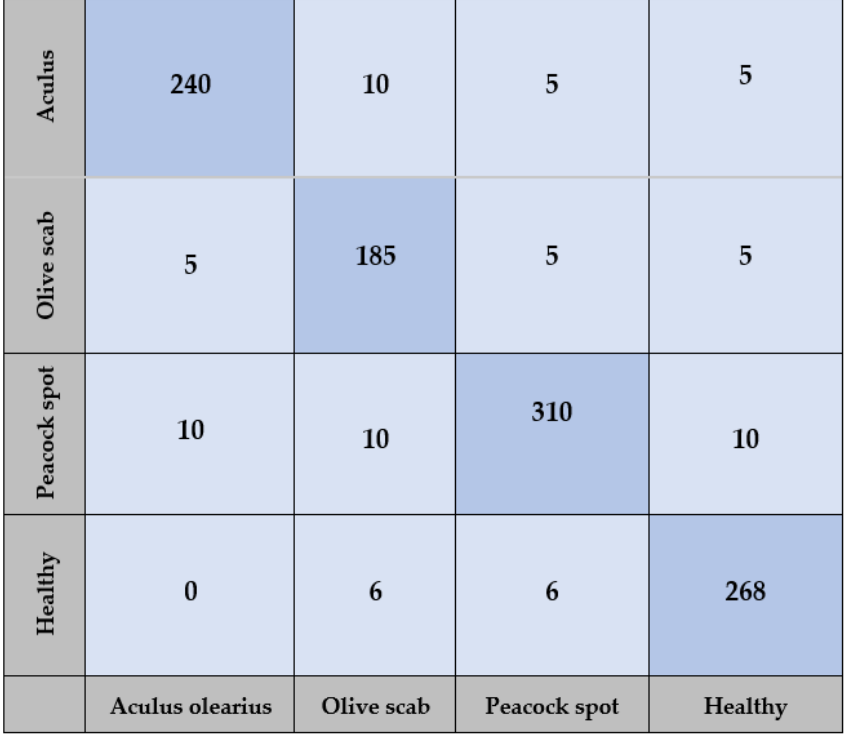
Figure 11. Confusion matrix for the ResNet50 model.